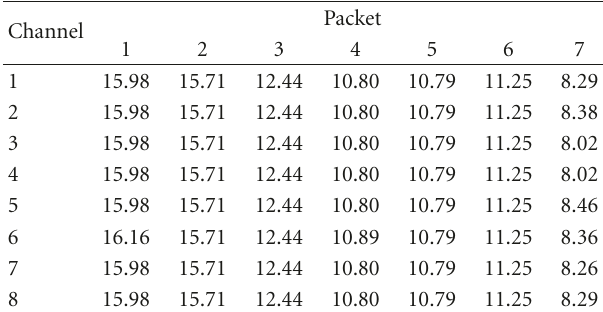
Table 5: Doppler shift estimation in moving-source transmission (Hz).